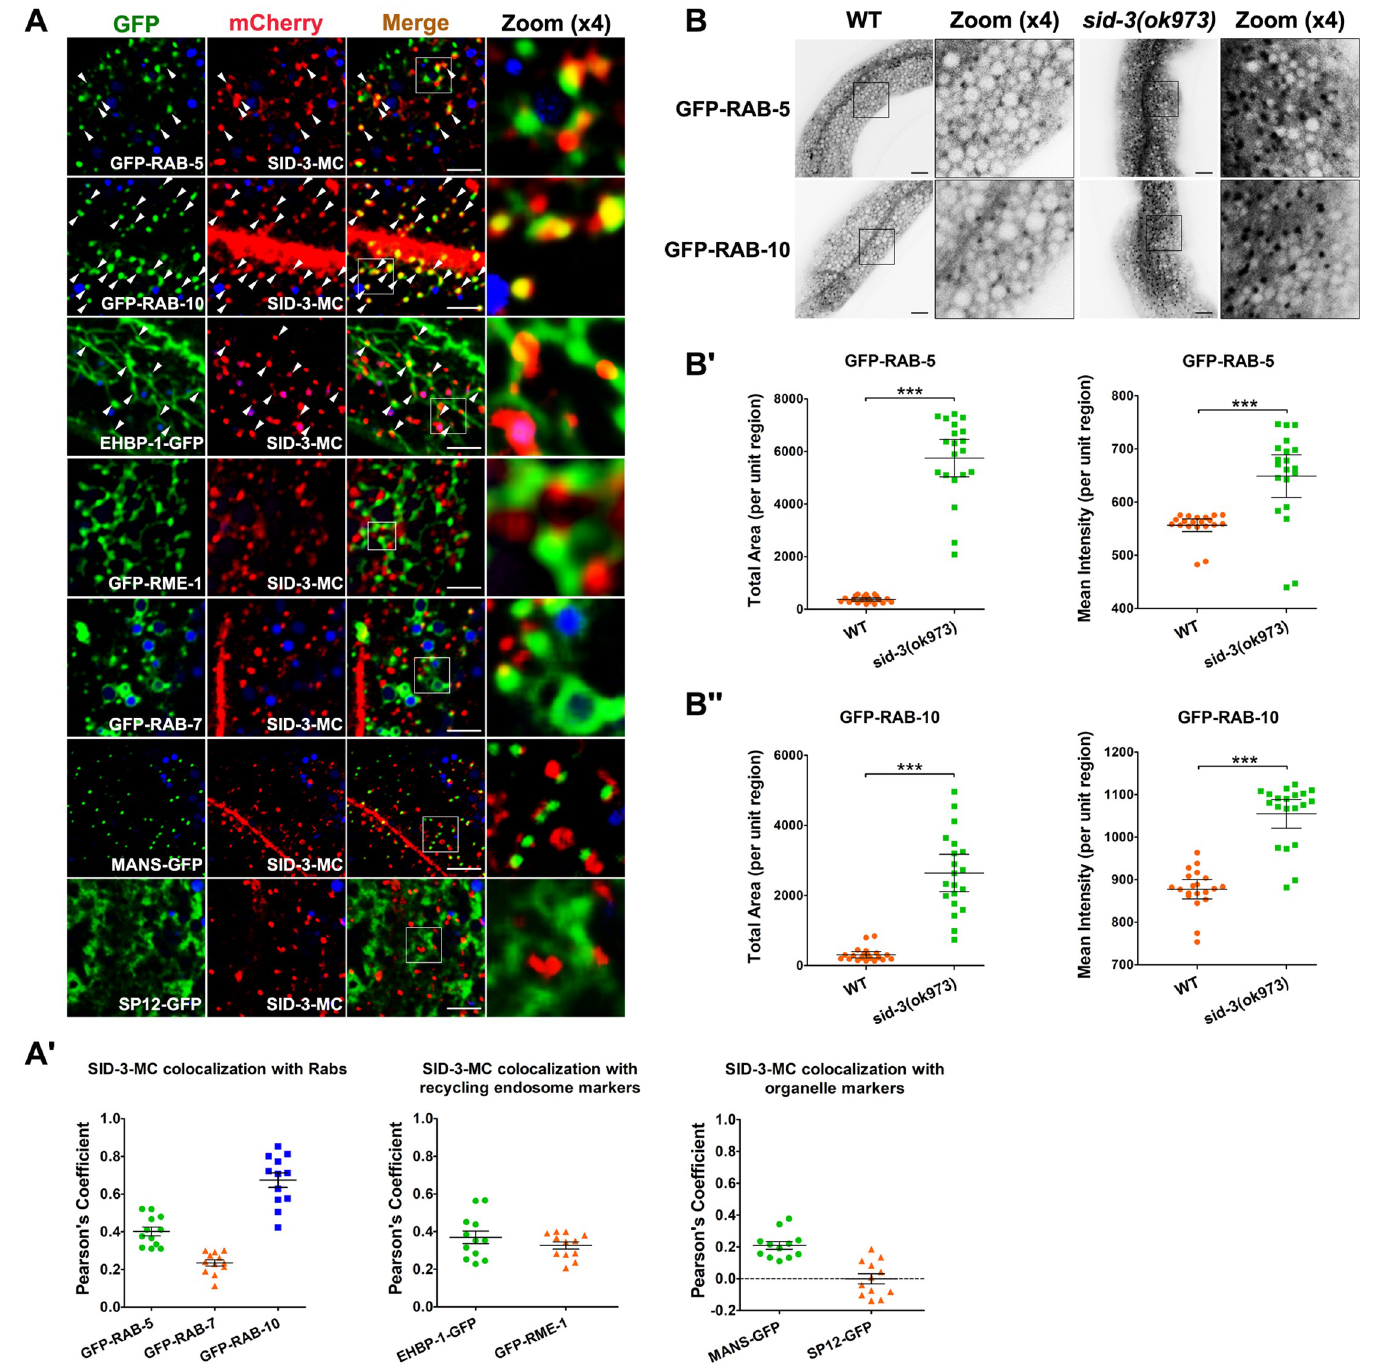
Fig 2. SID-3 localizes in basolateral endosomes. ( A-A’ ) Confocal image showing colocalization between SID-3-mCherry and organelle markers in the intestinal cells. SID-3-mCherry colocalizes with early endosomal marker GFP-RAB-5. Also, SID-3-mCherry colocalizes well with GFP-RAB-10. SID-3-mCherry resides in the EHBP-1- and RME-1-labeled recycling endosomal tubules. SID-3-mCherry displayed little colocalization with late endosome marker GFP-RAB-7, Golgi marker MANS-GFP, and ER marker SP12-GFP. Arrowhead indicates a positive overlap. DAPI channel (blue color) indicates broad-spectrum intestinal autofluorescence caused by lipofuscin- positive lysosome-like organelles. Pearson’s correlation coefficients for GFP and mCherry signals are calculated, error bar is 95% CI (n = 12 animals). ( B-B 0 ) Confocal images showing early endosomal marker GFP-RAB-5 and sorting endosomal marker GFP-RAB-10 in the intestinal cells. In sid-3(ok973) mutants, RAB-5 and RAB-10 labeled structures accumulated on intracellular structures. Error bars are 95% CIs (n = 20 each). Asterisks indicate the significant differences in the Mann-Whitney test ( ��� p < 0.001). Scale bars, 10 μ m. See S2 Table for quantitative data in this figure.